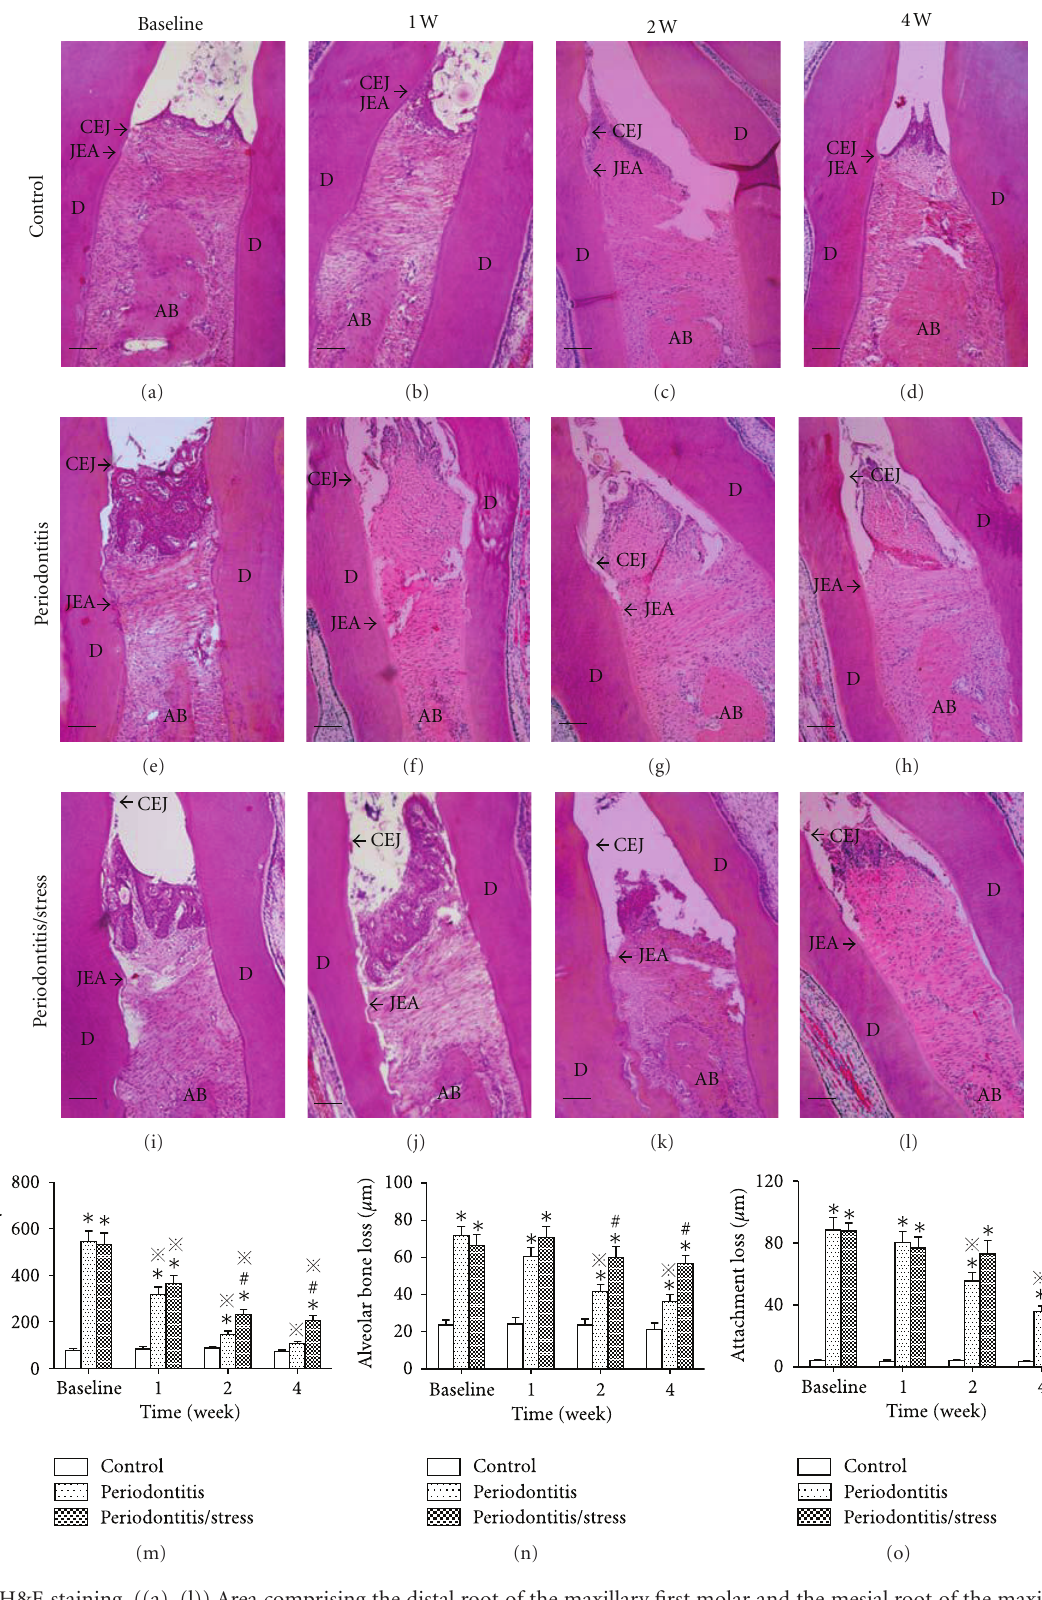
Figure 5: H&E staining. ((a)–(l)) Area comprising the distal root of the maxillary first molar and the mesial root of the maxillary second molar of all groups at all time points (D: dentin, AB: alveolar bone, CEJ: cement-enamel junction, and JEA: junctional epithelial attachment, 100, bar represents 150 μ m). ((m)–(o)) Histologic analysis of the surface of inflammatory infiltration (m), alveolar bone loss (n), and (cid:0) 0 . 05 versus control group at the same time point. # P attachment loss (o) of the rats in all groups. (cid:0) P (cid:0) 0 . 05 versus the same group at the same time point. (cid:2)(cid:0) P (cid:0)